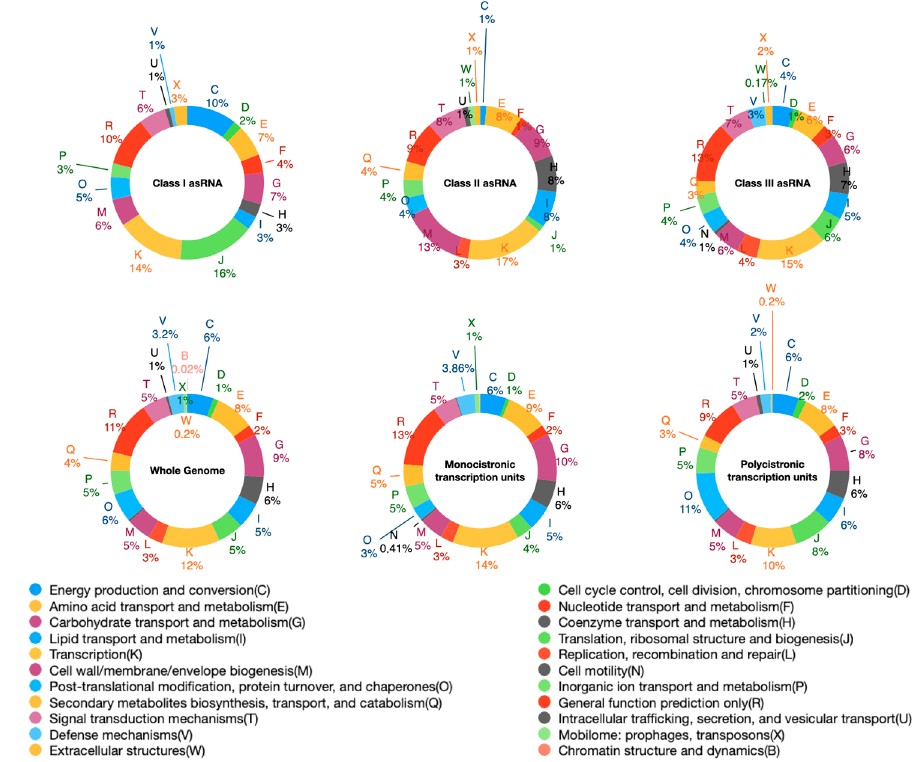
Figure 4. Functional classification of CDSs arranged in monocistronic or polycistronic transcripts and CDSs targeted by asRNAs (I, II, and III). CDSs that are predicted targets of asRNAs I, asRNAs II, and asRNAs III are classified according to Clusters of Orthologous Groups (COGs). As references, COGs classification of whole genome CDSs, and CDSs in monocistronic and polycistronic transcriptional units are also shown. Genes with unknown functions are excluded from the representation.